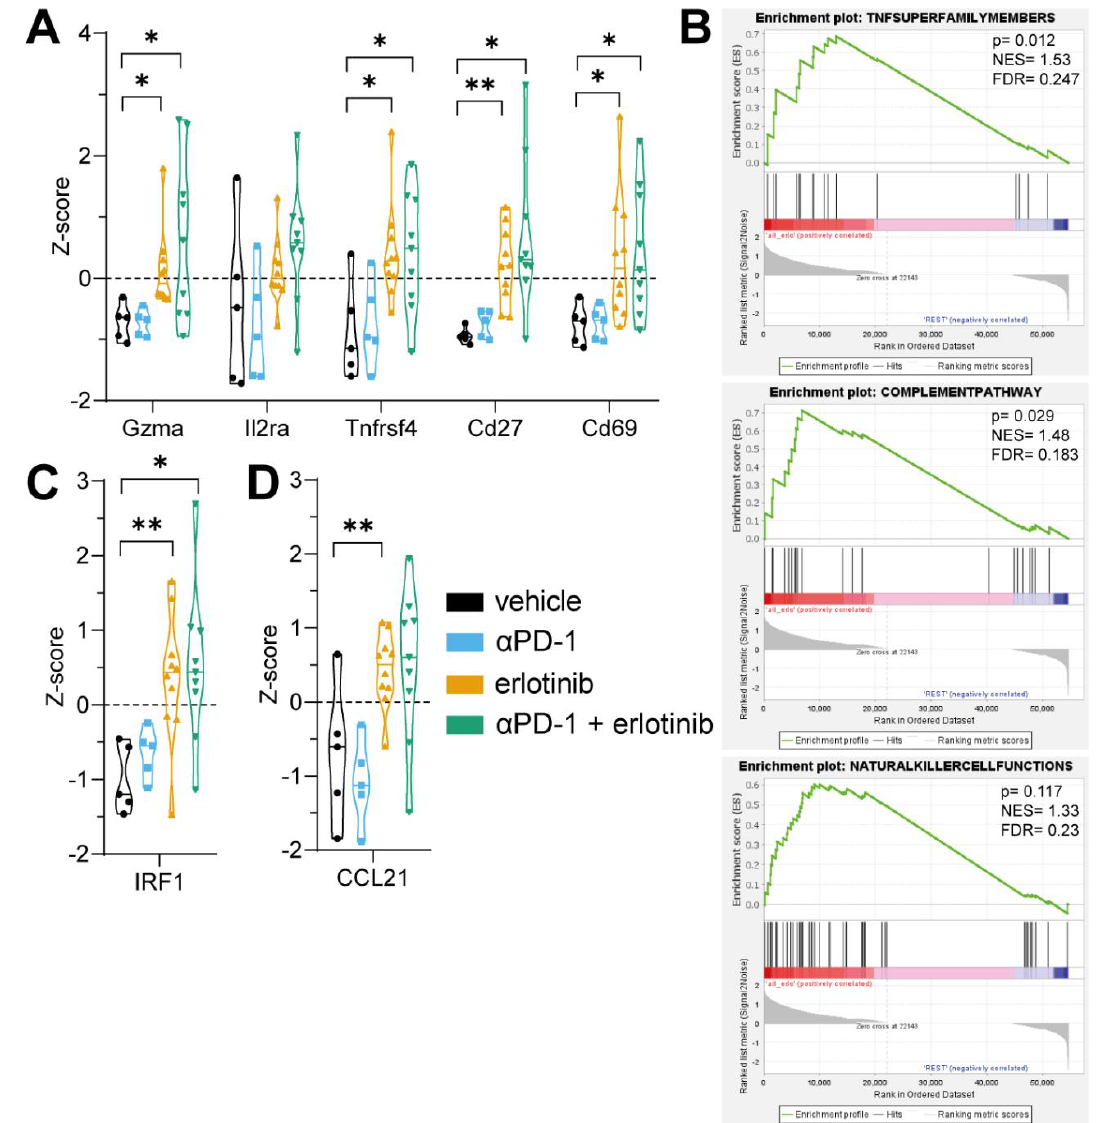
Figure 3. Inhibition of EGFR increases active phenotype of immune cell infiltrate in EGFR-driven tumours. ( A ) Mean gene expression z -scores of immune cell activation markers ( n = 5 – 10 mice per group). ( B ) Gene set enrichment analysis for different gene sets from any erlotinib-treated mice (namely, erlotinib and aPD − 1 + erlotinib groups) against the others (vehicle and aPD − 1 groups). ( C , D ) Mean gene expression z -score of transcription factor mediating tumour-suppressive functions and intratumoural chemokines, respectively ( n = 5 – 12 mice per group). ( A , C , D ) Data are shown as violin plots; the statistical test used was Student’s t -test (statistically significant changes are indicated as follows: * p < 0.05; ** p < 0.01).